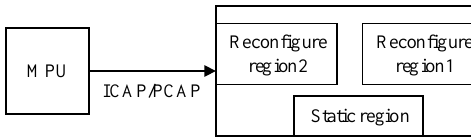
Figure 1. Dynamically partially reconfigurable (DPR)